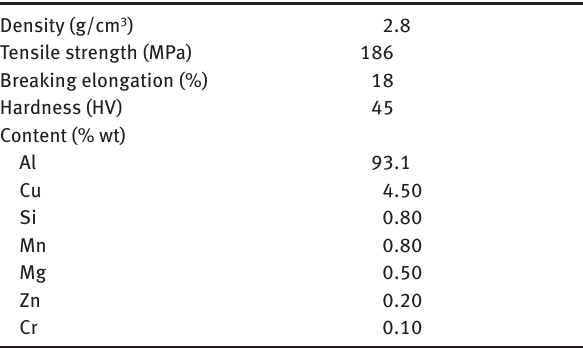
Table 1: Mechanical properties and chemical composition of Al 2014